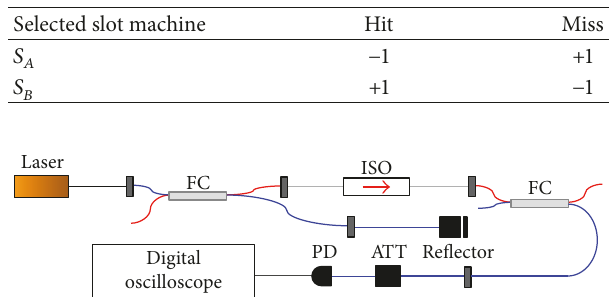
Table 1: Value of 𝑋(𝑡) .